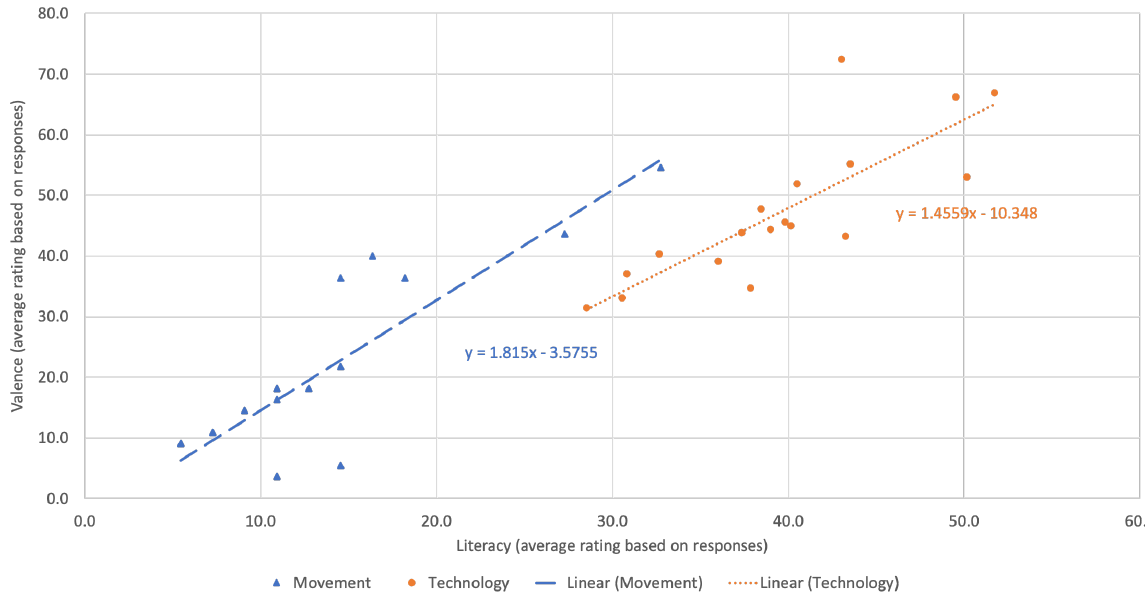
Figure 9: Each participant’s Movement scores for Literacy and Valence plotted as one point (a blue triangle), as well as each participant’s Technology scores for Literacy and Valence plotted as one point (an orange dot). The linear regression line for Movement and linear re- gression line for Technology applied. While both Movement and Technology show a positive correlation between Literacy and Valence, Movement has a slightly more positive relationship (with a slope of 1.815) than Technology (with a slope of 1.456). The average value for